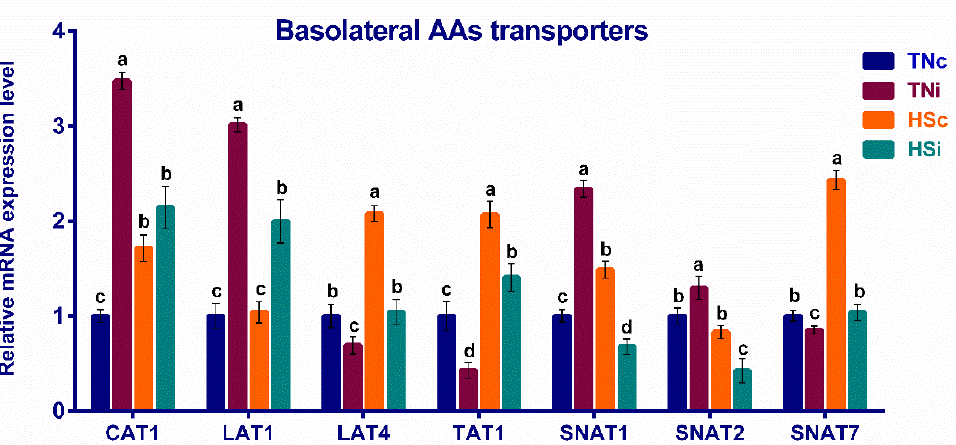
Figure 4. The mRNA fold expression of the ileal basolateral amino acid transporters at 6 dpi of E. maxima infected chickens raised under thermoneutral (TNi) and heat-stress (HSi) conditions, as compared to uninfected control chickens raised under thermoneutral (TNc) or heat-stress (HSc) conditions (N = 5). Assays were run in triplicate. RT-qPCR expression results were depicted as 2 −ΔΔCt . Significant differences ( p < 0.05) are depicted by different letters. The error bars represent the SEM.